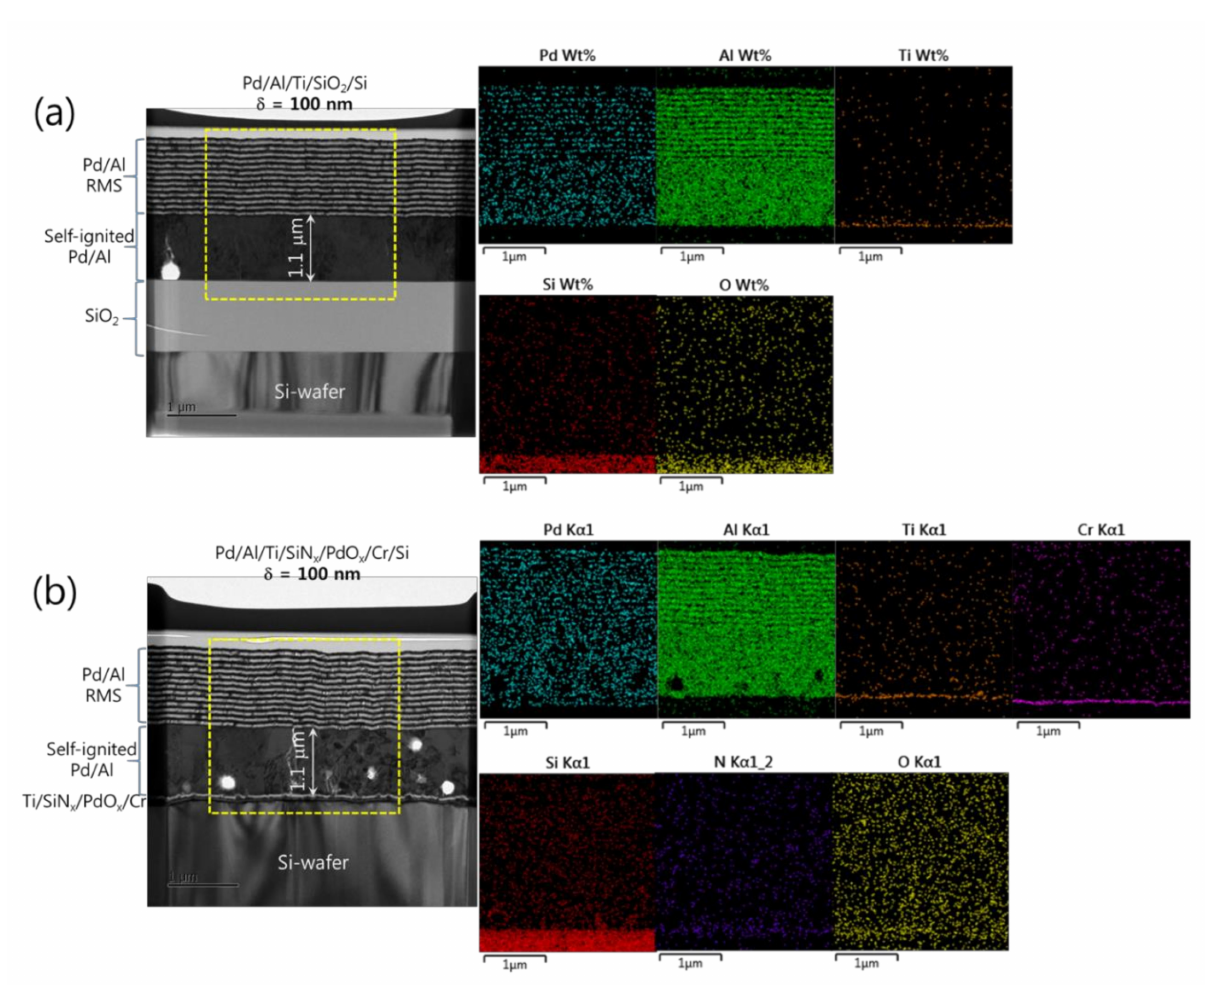
Figure 5. TEM cross sections ( left ) and corresponding EDS elemental mappings ( right ) of Pd/Al-iRMS with a bilayer thickness of δ = 100 nm and a bilayer number of N = 24. ( a ) Pd/Al-iRMS grown on a SiO 2 -coated Si-wafer; ( b ) Pd/Al-iRMS grown on a PdO x -buffered